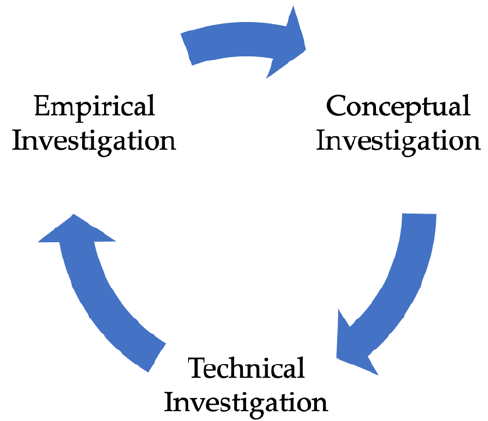
Figure 7. The tripartite iterative Value Sensitive Design methodology. 441